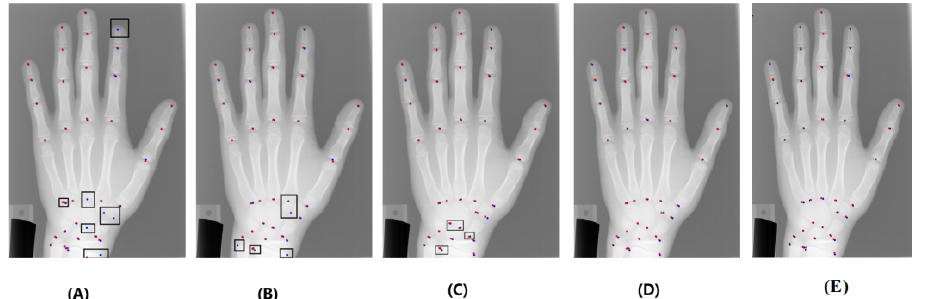
Figure 7. Landmark detection examples on hand radiograph images. The blue points represent the ground truth, and the red points represent prediction from different models: column ( A ), Unet4; column ( B ), Unet4 (Fast-KD on UNet5); column ( C ), Unet4 (FSF-LD on UNet5); column ( D ), Unet4 (Fast-KD on SEG-UNet5); column ( E ), Unet4 (FSF-LD on SEG-UNet5).